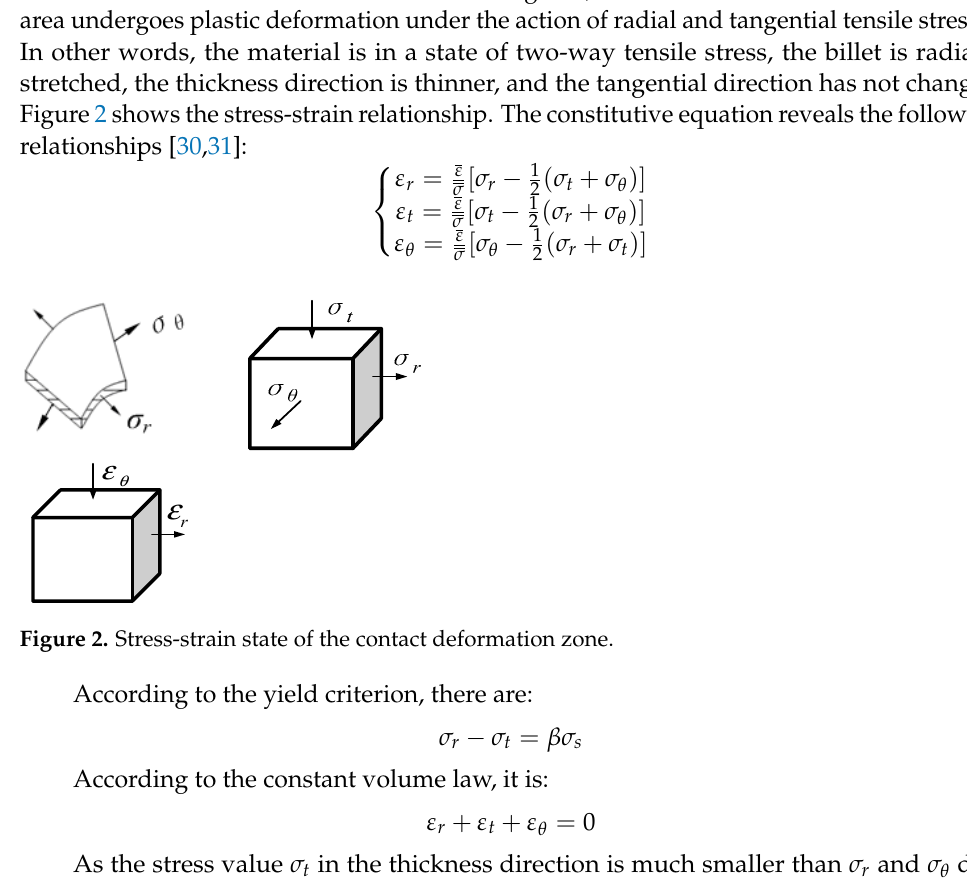
Figure 2. Stress-strain state of the contact deformation zone.